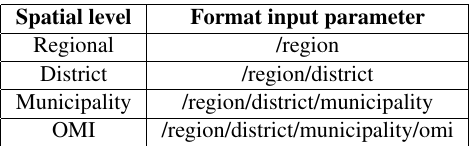
Table 4. description of the different input formats that the getStat function can take on. The format changes based on the level of spatial granularity